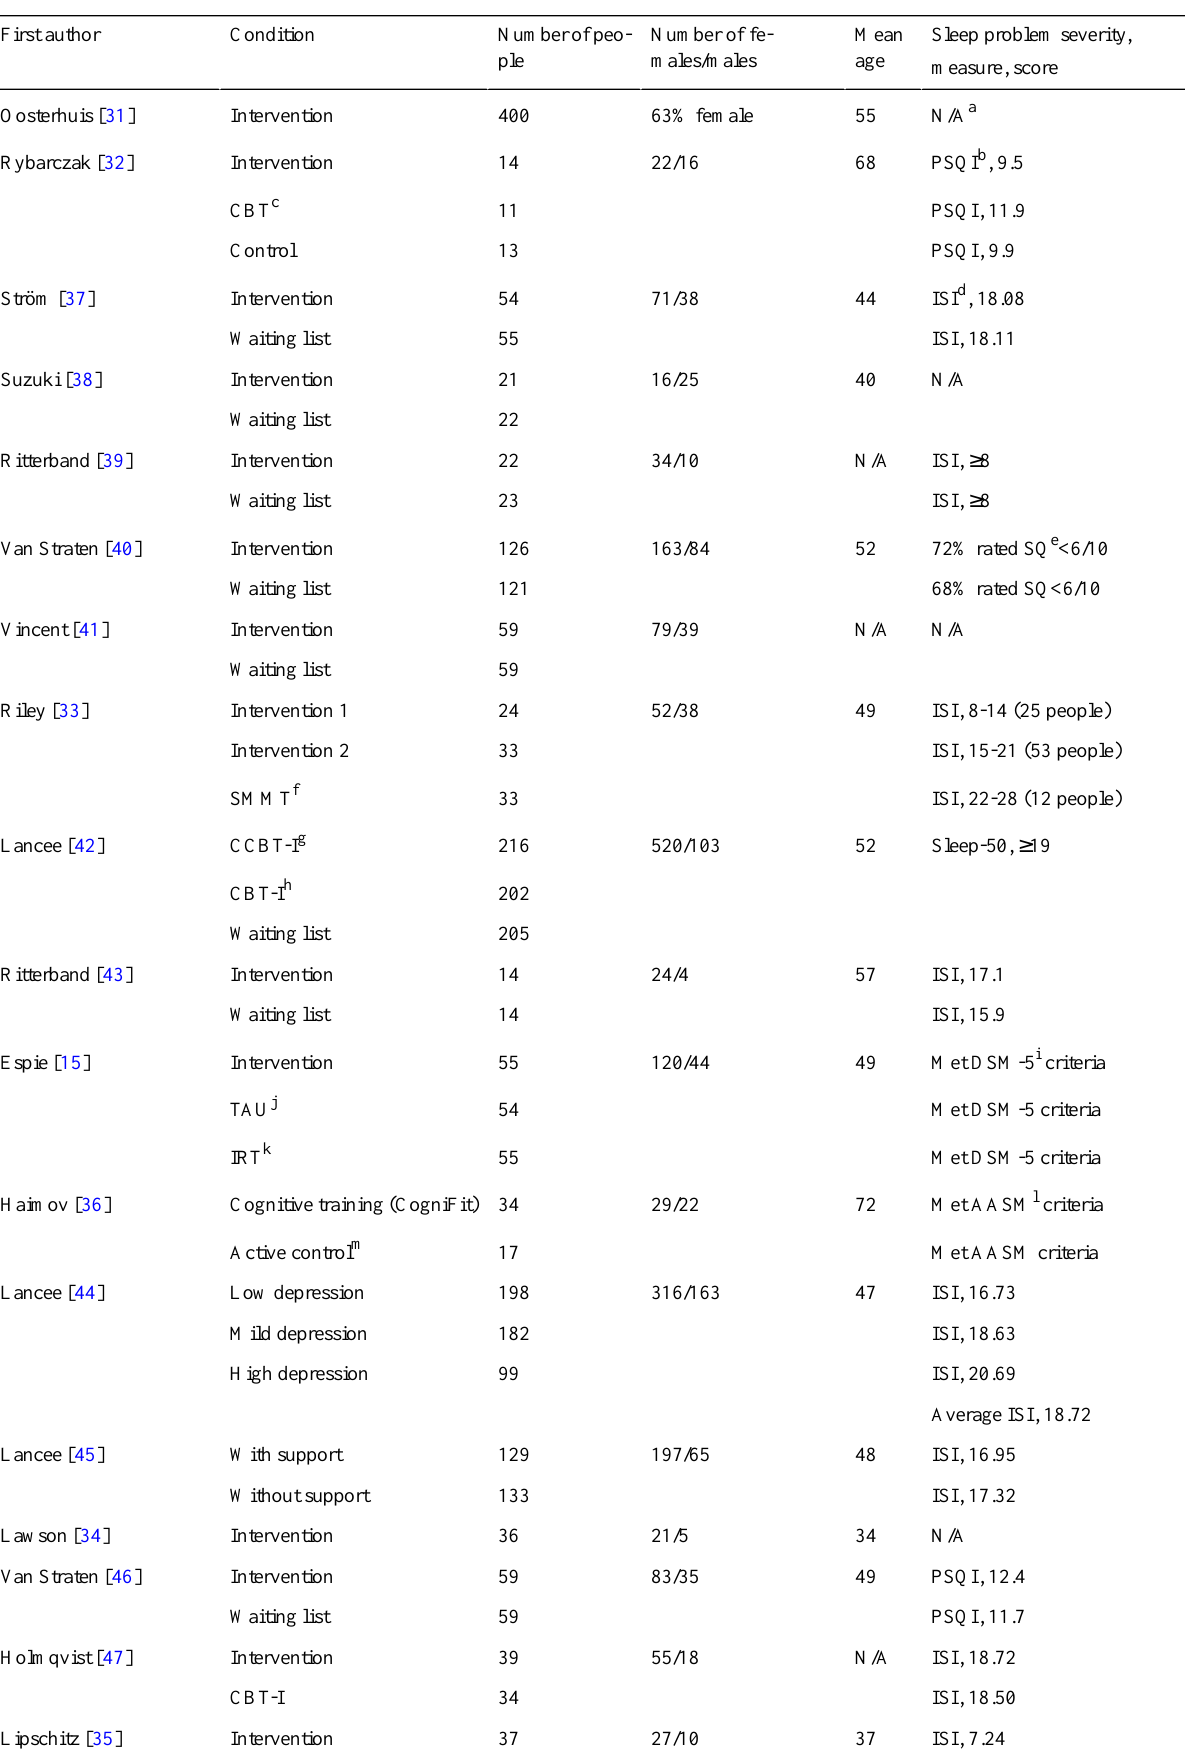
Table 1. Characteristics of included